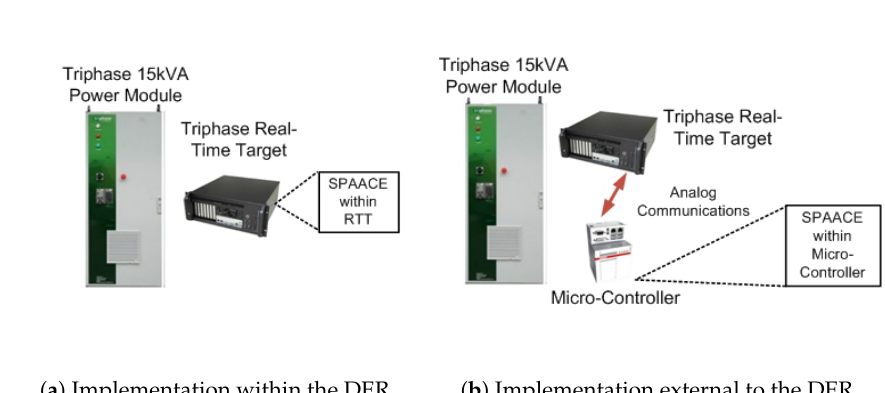
Figure 3. Network and test configurations within the